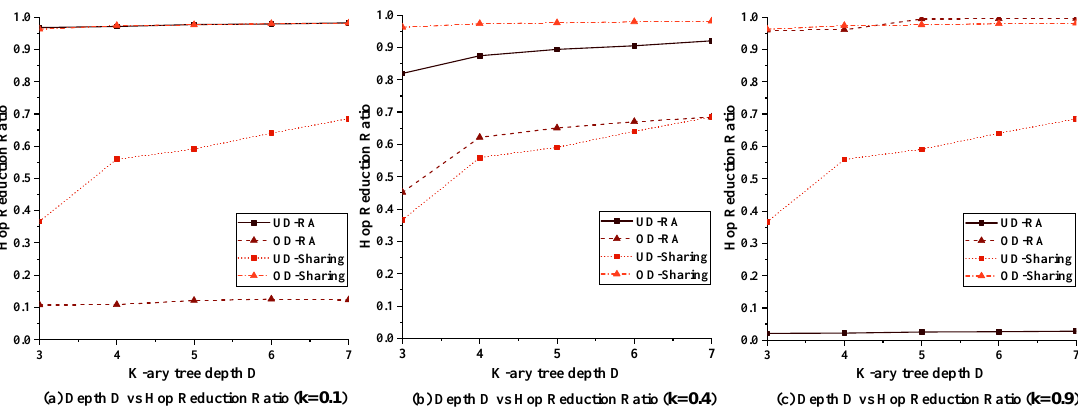
Figure 8. Caching performance vs. tree depth in terms of hop reduction ratio when varying k . Regarding the resource allocation strategy, the results differ depending on the k